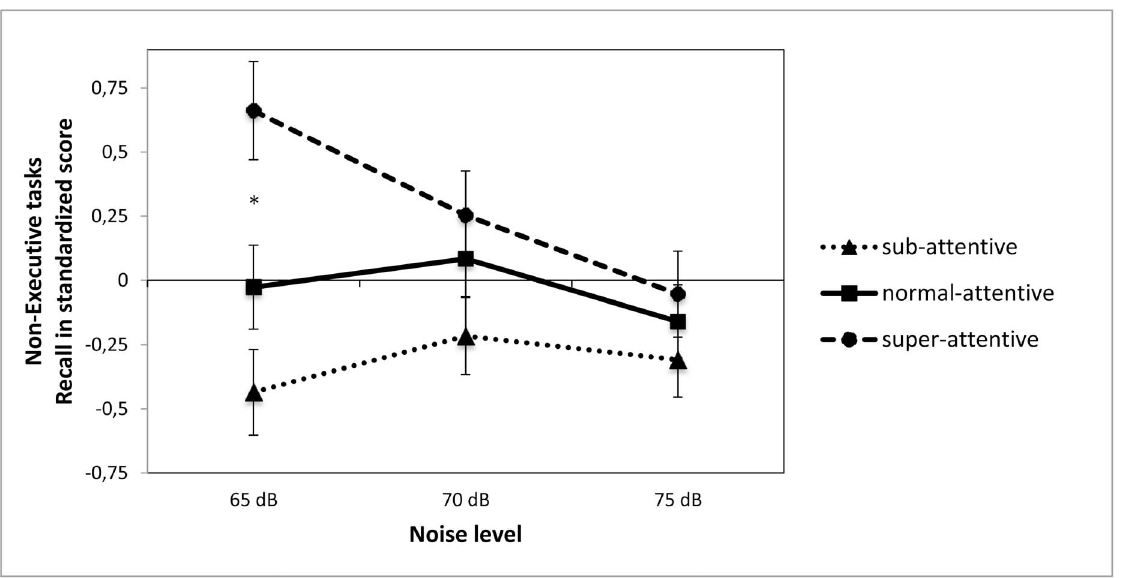
Figure 1. Performance on executive function tasks as a function of attention ability and noise level. Note: White noise levels were 65, 75, 85 dB; * indicates a significant difference between groups in the 65 dB condition ( F (2,86)=6.36, p =.003).